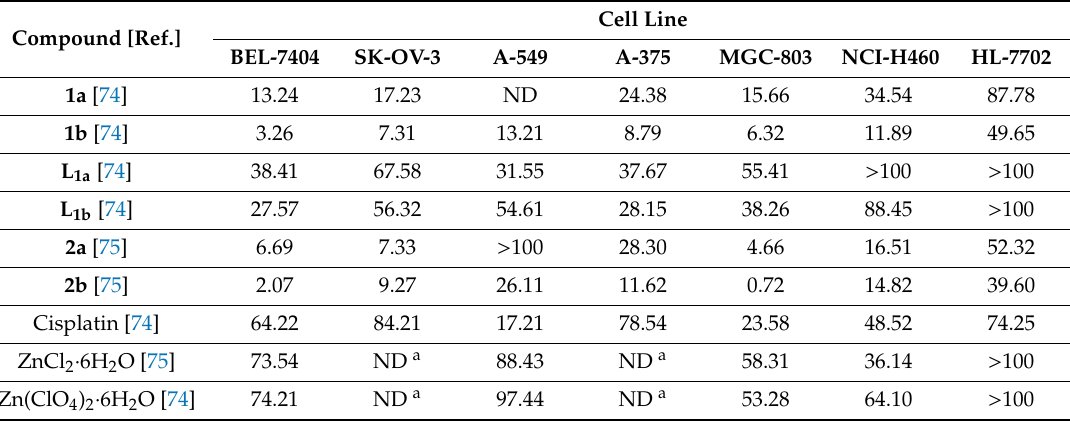
Table 1. IC 50 values ( µ M) for zinc complexes 1a , 1b and 2a , 2b , ligands L 1a and L 1b and the reference compounds cisplatin, ZnCl 2 and Zn(ClO 4 ) 2 against different human tumor and normal (HL-7702) cell lines, after an incubation time of 48 h. Compound [Ref.]